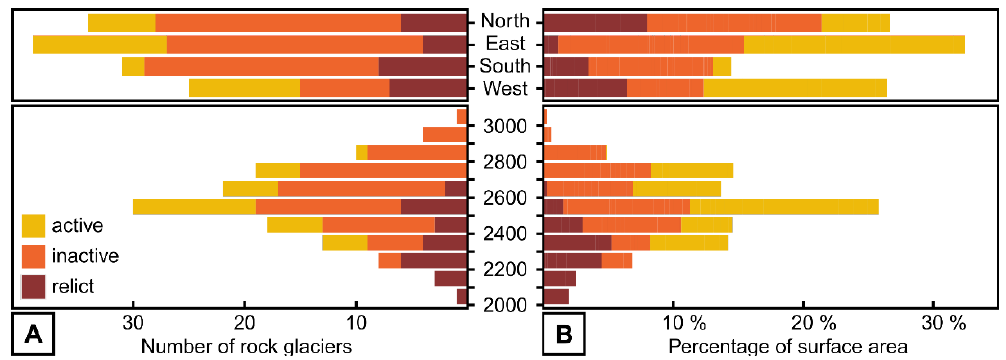
Figure 5. Distribution of active, inactive and relict rock glaciers in the Kaunertal catchment, shown as (A) absolute numbers and (B) percentage share of the total surface area. Upper panel groups rock glaciers in four aspect classes (North, East, South, West), lower panel shows rock glaciers dissolved for elevation bins of 100 m.